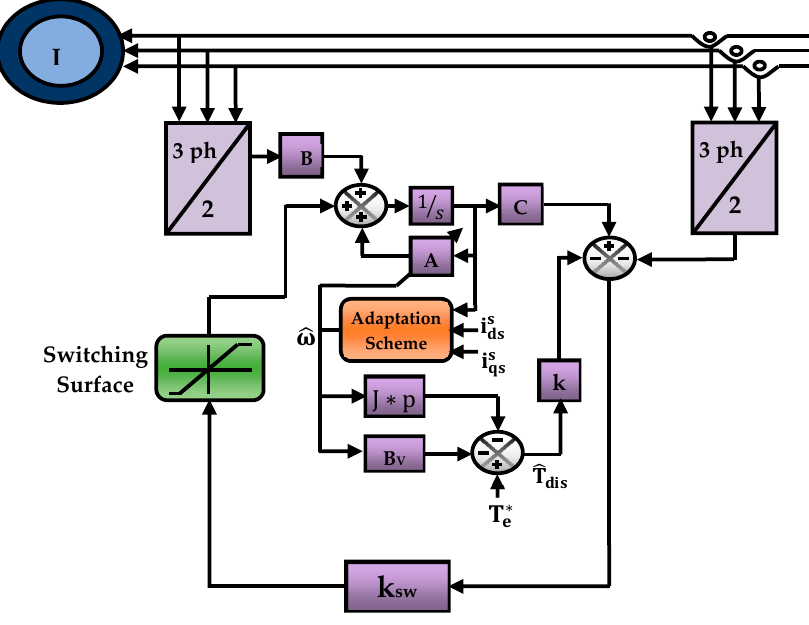
Figure 4. Proposed state observer with the modified switching hyperplane.